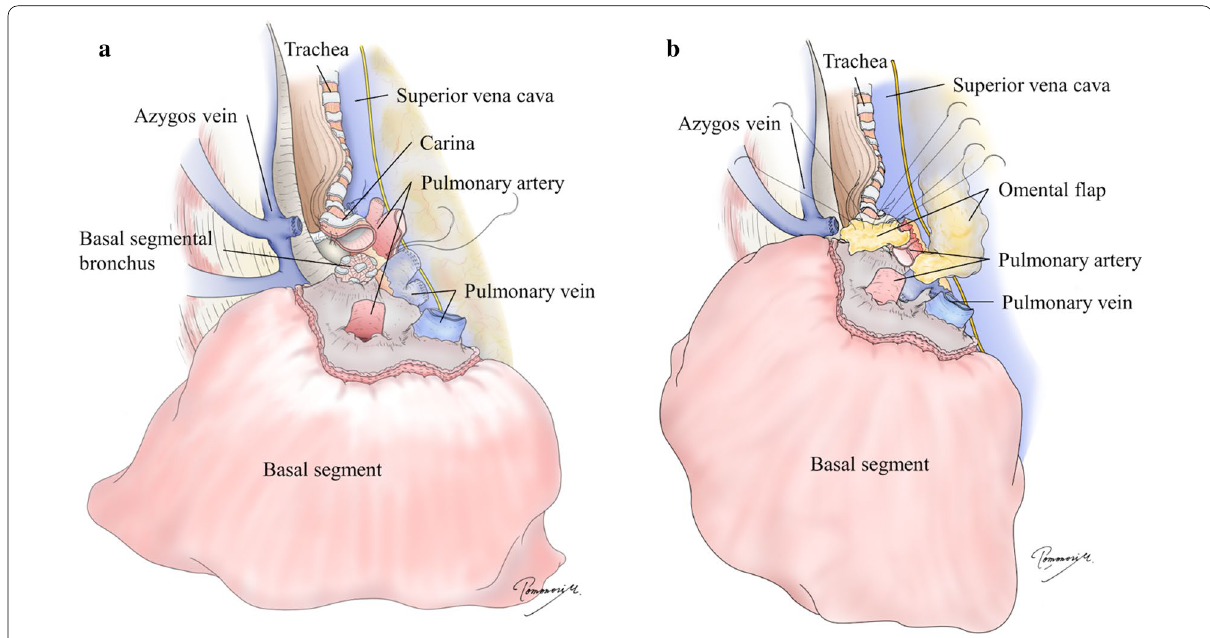
Fig. 4 Surgical illustration showing autotransplantation of the basal segment. a Anastomoses of the basal segmental bronchus to the carina, the basal pulmonary artery to the right main pulmonary artery, and the basal pulmonary vein to the superior pulmonary vein. b Wrapping of the bronchial anastomosis with the omental